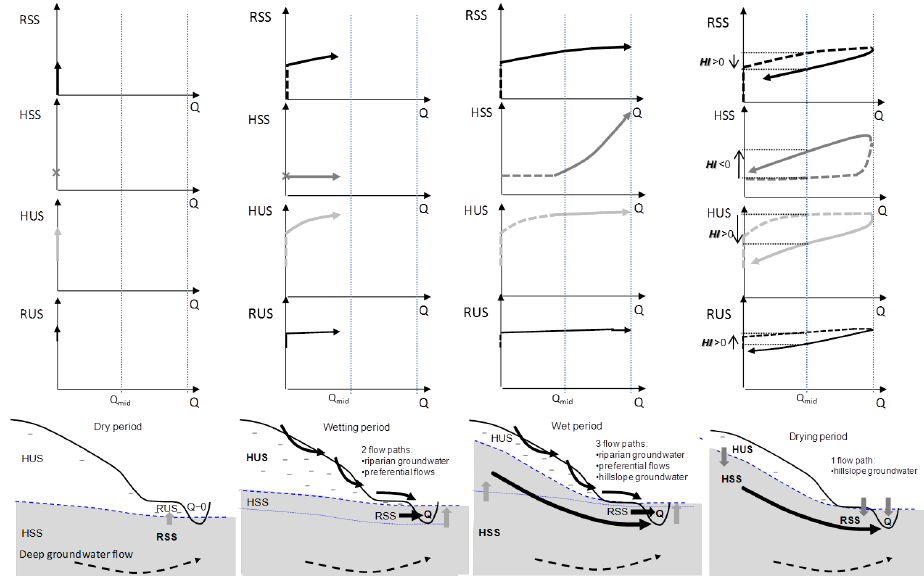
Figure 7. Conceptual scheme of successive mechanisms explaining the annual hysteresis between storages and stream flows. HUS: hillslope unsaturated storage; HSS: hillslope saturated storage; RUS: riparian unsaturated storage; RSS: riparian saturated storage; Q : stream flow. Bold characters indicate compartments with varying storage; grey arrows indicate whether the compartment is filling or emptying; black arrows indicate the water flow paths.